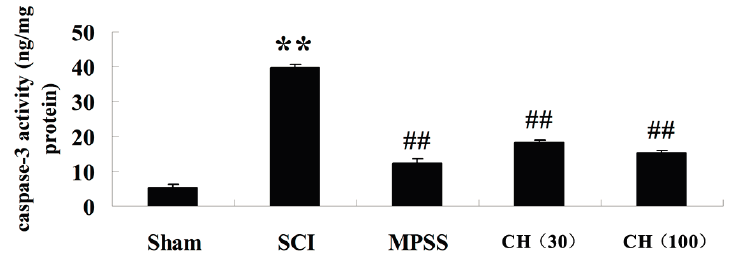
Figure 5. CH suppresses caspase-3 activity in spinal cord tissues after SCI ( n = 10, mean ± SD). ** p < 0.01 compared with the sham group; ## p < 0.01 compared with the SCI group. Sham, sham group; SCI, spinal cord injury group; MPSS, methylprednisolone-treated; CH (30), chrysin (30 mg/kg)-treated; CH (100), chrysin (100 mg/kg)-treated